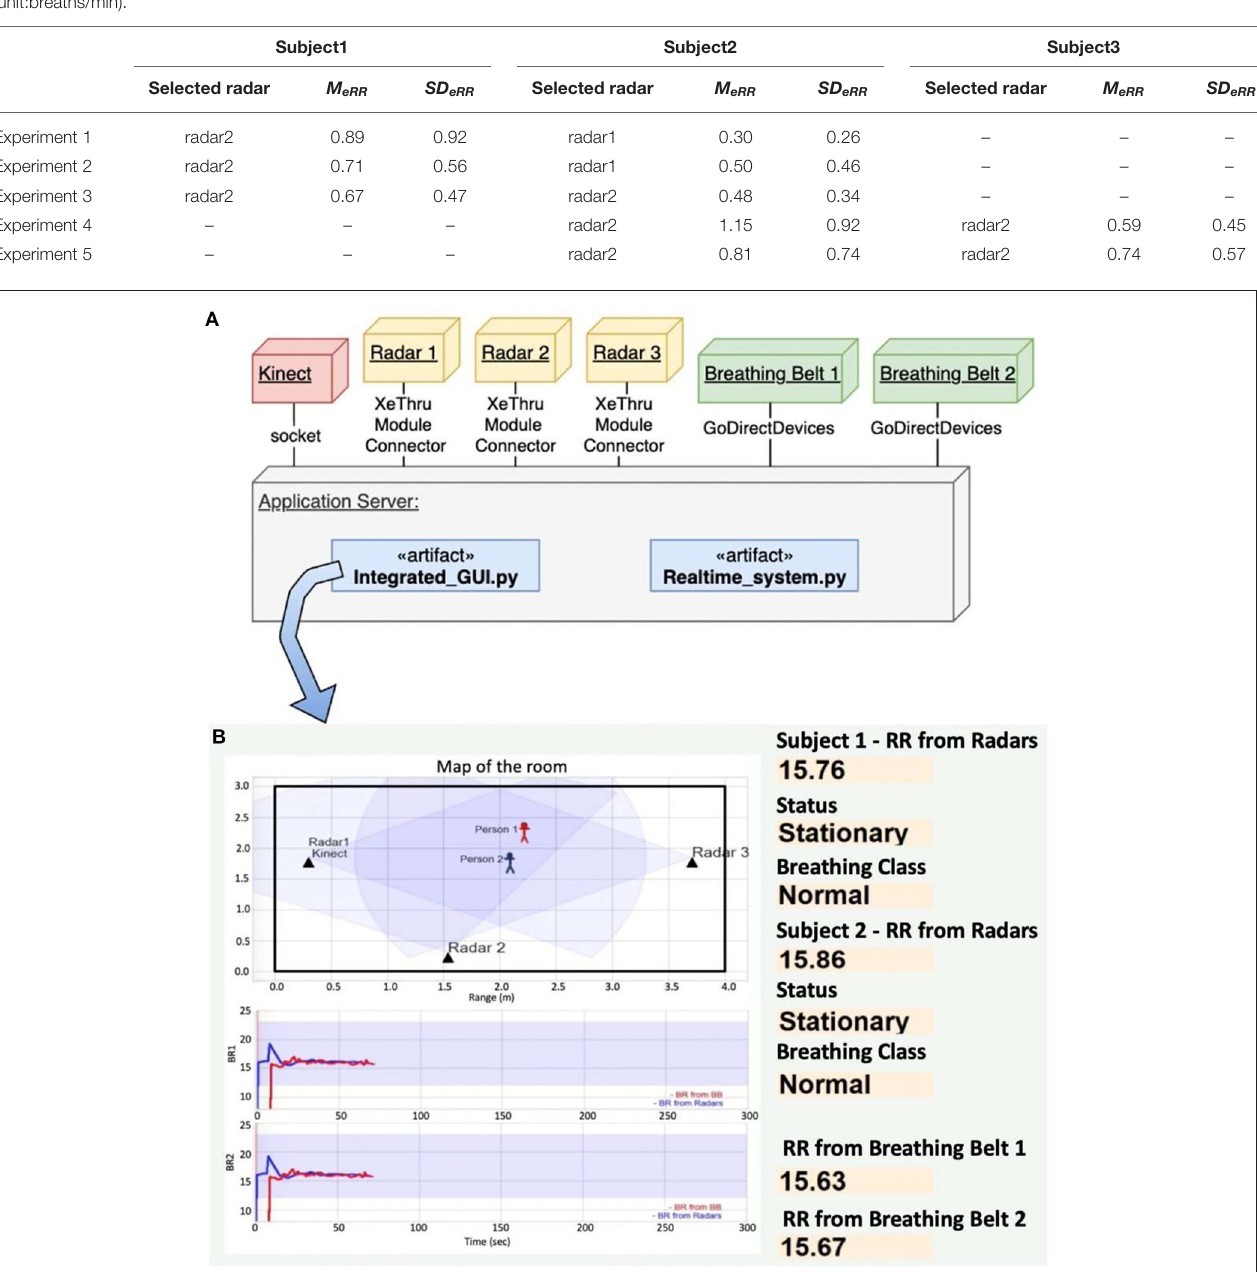
FIGURE 10 | (A) Deployment diagram of our near real-time system, (B) GUI that shows the estimated location of two subjects on the top left, reference (blue) and radar-estimated (red) RRs for subject 1 (graph in the middle and subject 2 (graph on the bottom), and the estimated RRs and patterns for the current 15 s windows on the